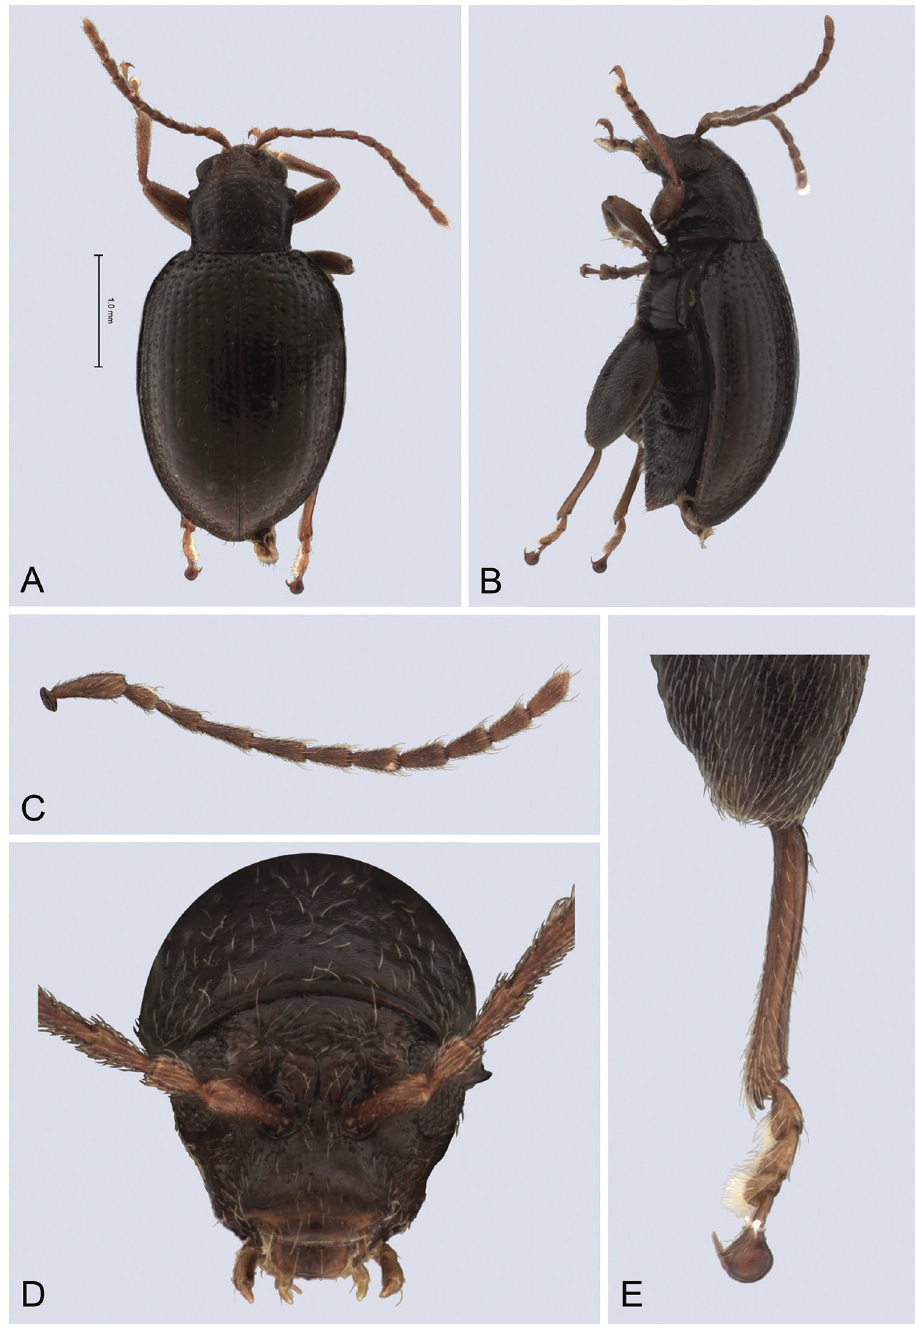
Figure 19. Andersonoplatus merga . A Habitus dorsal B Habitus lateral C Antenna D Head, frontal view E Hind